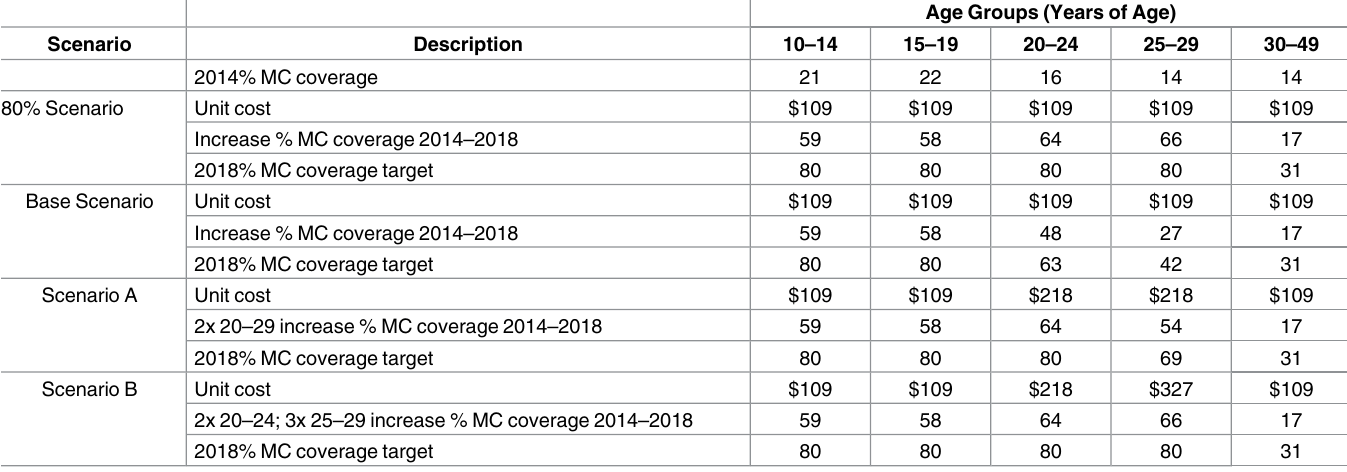
Table 1. Target Coverage by 2018 for Three